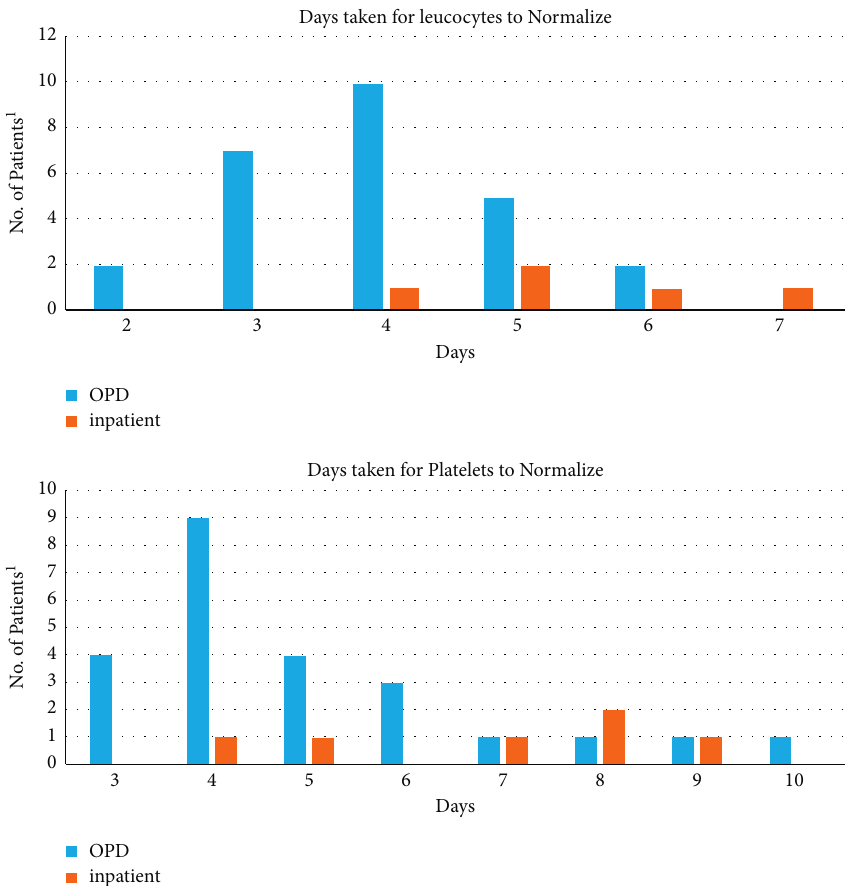
Figure 3: Time taken for the normalization of total leucocyte counts (TLC) and platelet counts (PLT) in patients who had deranged counts during the illness. PLTimproved later than TLC. Maximum normalization occurred around 4 days after the time the values first deteriorated from normal. 1 39/93 (41%) patients had deranged blood